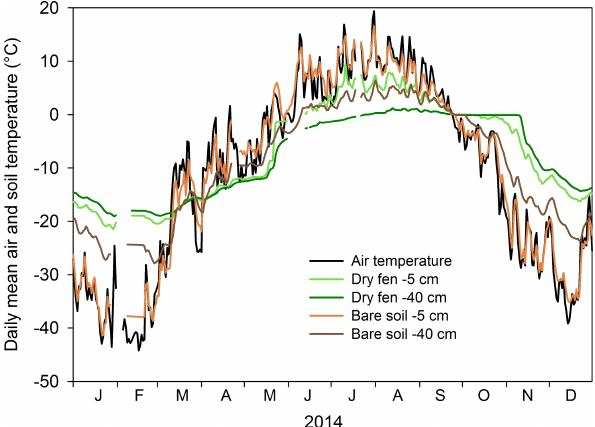
Figure 1. Mean daily air temperature at the study area and the con- comitant soil temperatures, measured 5 and 40cm below ground surface at two field spots classified as bare soil and dry fen, in 2014.